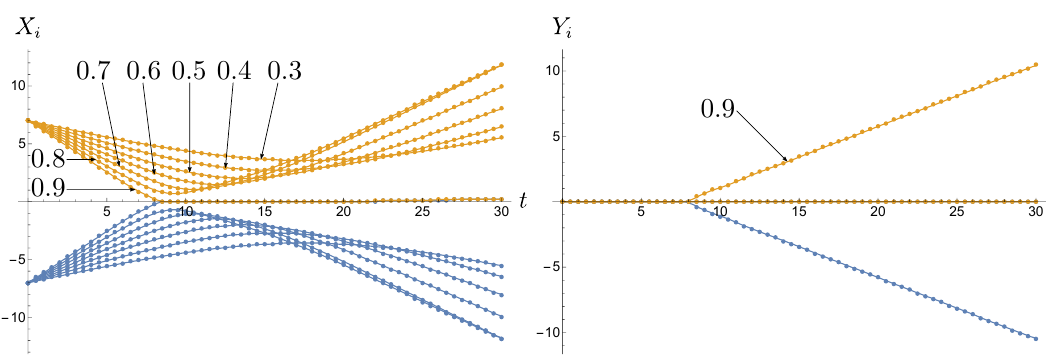
Figure 32 . Trajectories X i ( t ) and Y i ( t ) of two anti-parallel non-Abelian vortices of type I*, for initial velocities u = 0 . 3 , 0 . 4 , · · · , 0 . 9 (marked on the plots for clarity).